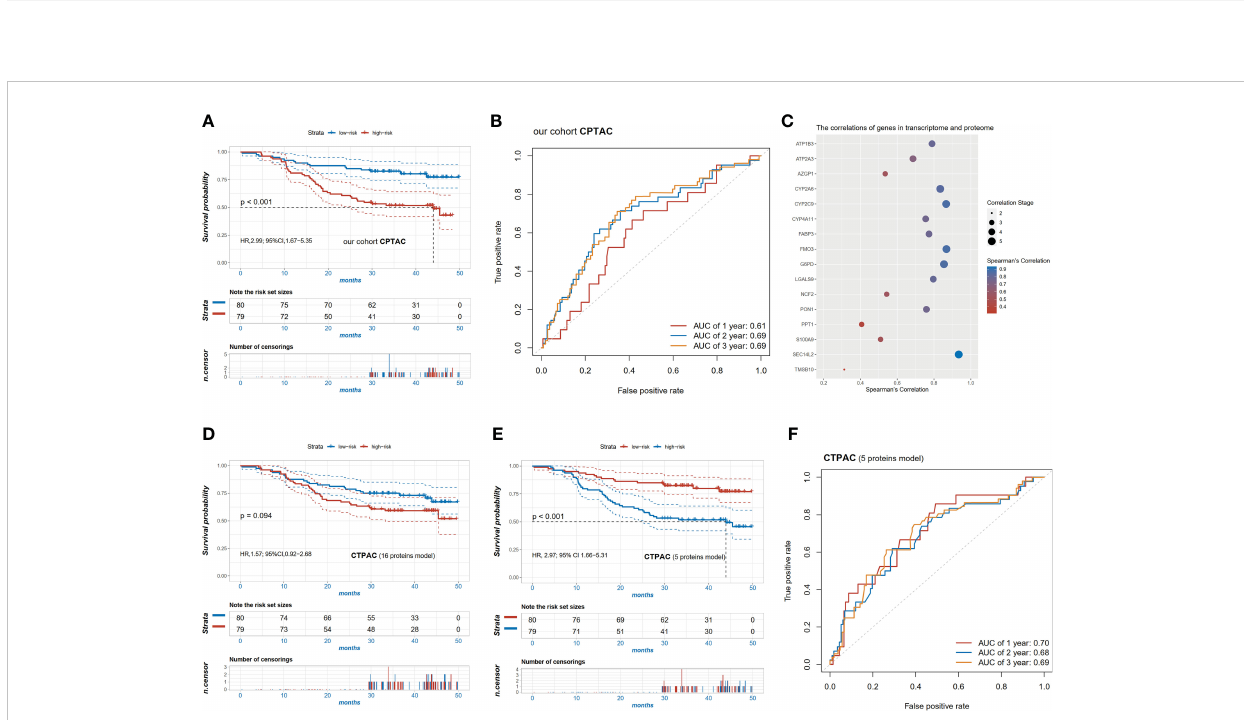
FIGURE 5 Validation of the pyroptosis-related signature in the cohort CPTAC. (A) Kaplan-Meier survival curves of high and low risk patients in the CPTAC cohort; (B) ROC curve in the CPTAC cohort; (C) the signi fi cant correlation of 16 signature genes (p<0.05) between transcriptome and proteome; (D) Kaplan-Meier survival curves of high and low risk patients based on the 16 protein levels in proteome; (E) Kaplan-Meier survival curves of high and low risk patients based on the 5 protein levels (r 2 >0.8) in the proteome; (F) ROC curve of the risk scores of the 5 proteins in the CPTAC